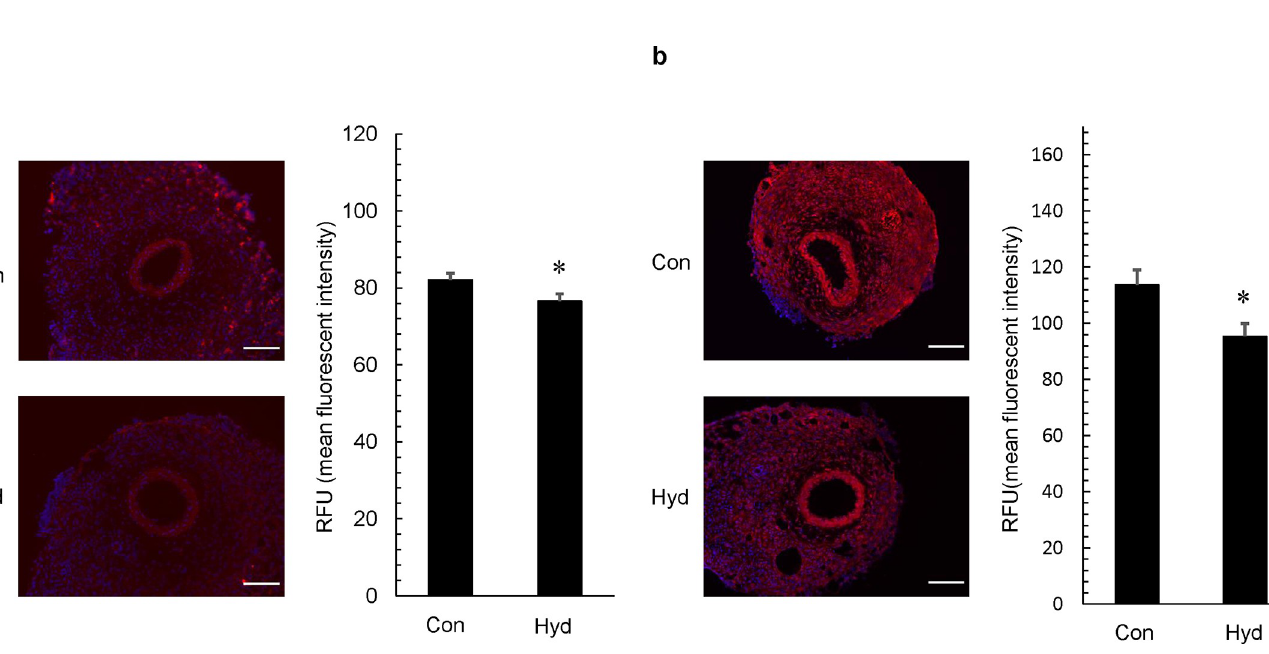
PLOS ONE | https://doi.org/10.1371/journal.pone.0227582 April 17,